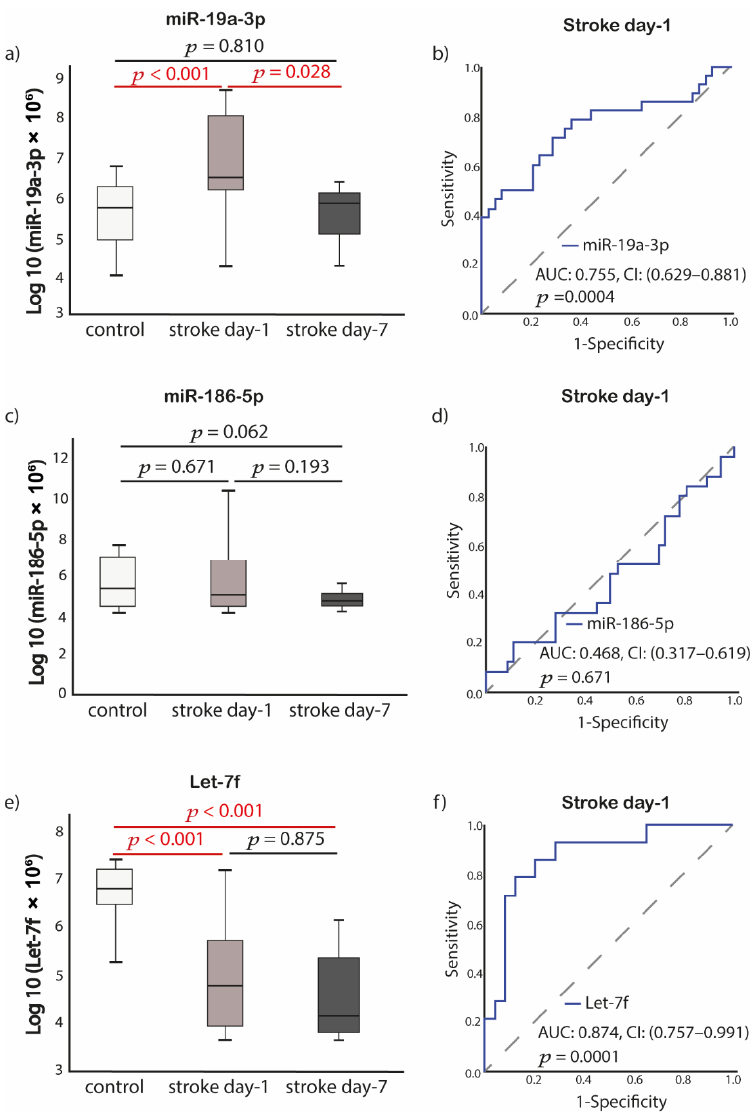
Figure 4. Alterations of miRNAs expression among the groups and diagnostic value of miRNAs determined by ROC curve analysis. ( a ) miR-19a-3p; ( b ) ROC analysis of miR-19a-3p from stroke day-1; ( c ) miR-186-5p; ( d ) ROC analysis of miR-186-5p from stroke day-1; ( e ) Let-7f; ( f ) ROC analysis of Let-7f from stroke day-1. p value was calculated with Mann-Whitney U or Wilcoxon test, appropriately (Control samples n = 35, acute stroke day-1 samples n = 28 and stroke day-7 samples n = 20). Abbreviations: Log10, log10 transformation; miR, microRNA; p , value; AUC, area under the curve; CI, confidence interval; ROC, Receiver operating characteristic.